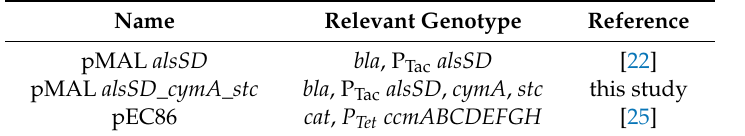
Table 2. Vectors used in this study.